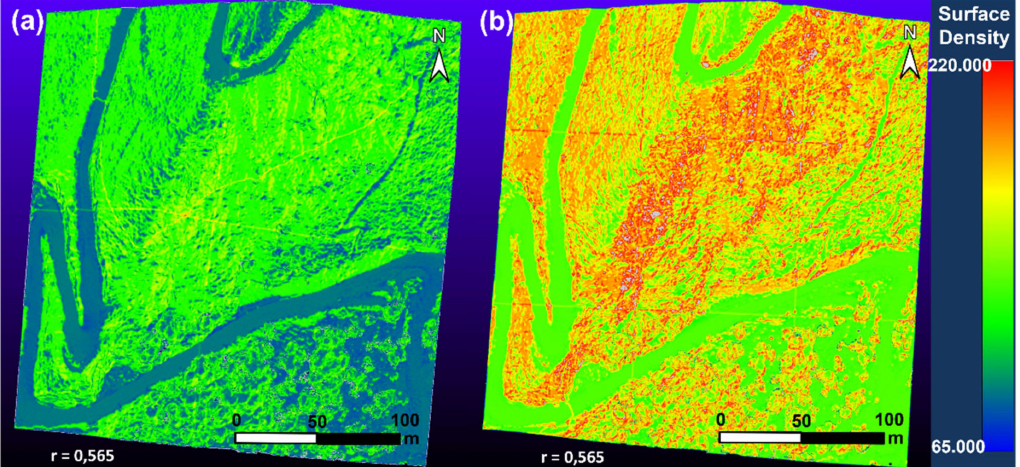
Figure 8. Point cloud surface density (pts / m 2 ) of ( a ) case A and ( b ) case B.